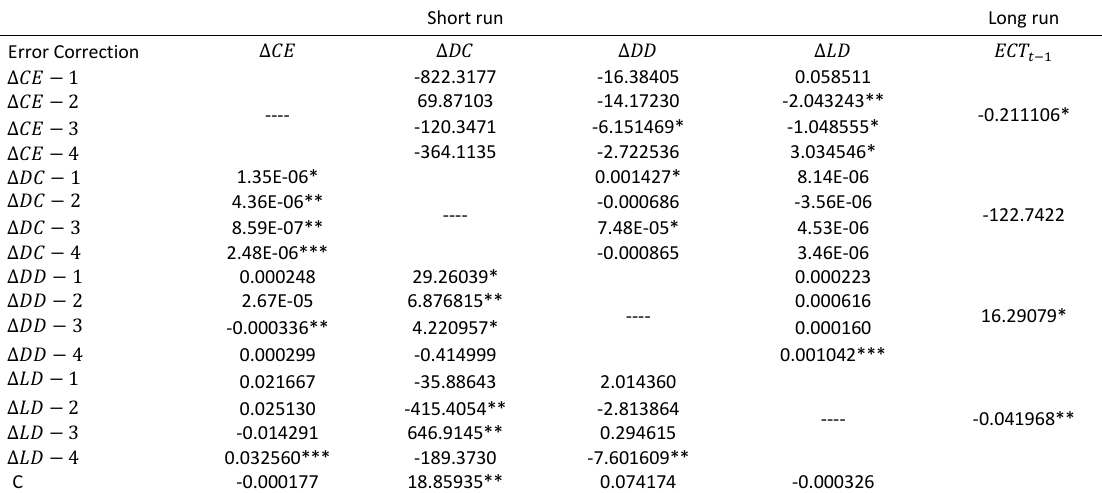
Table 5: Vector error correction for short-run and long run estimates